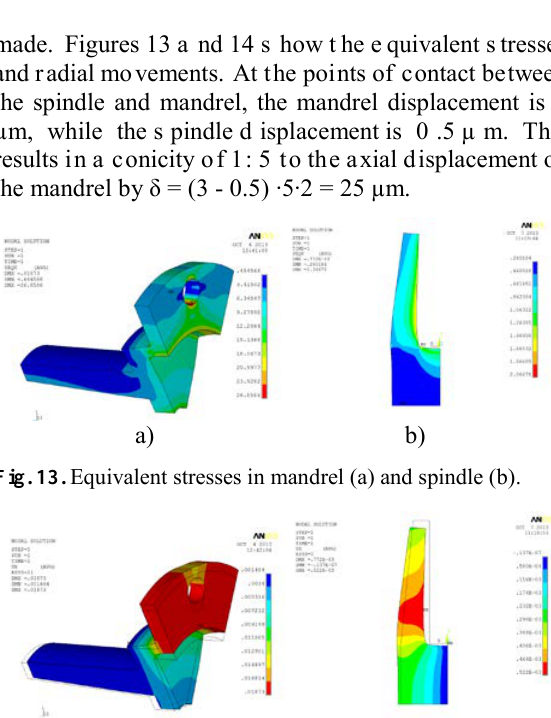
Fig. 11. Radial movements (a) and axial movements (b).